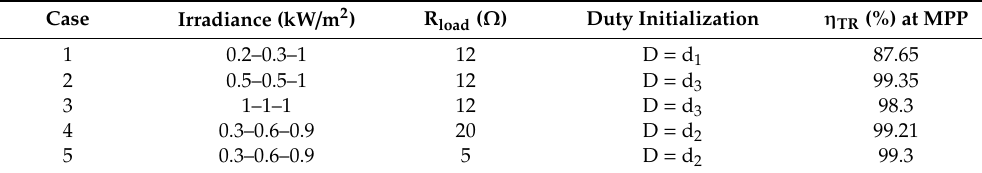
Table 2. Simulation results and